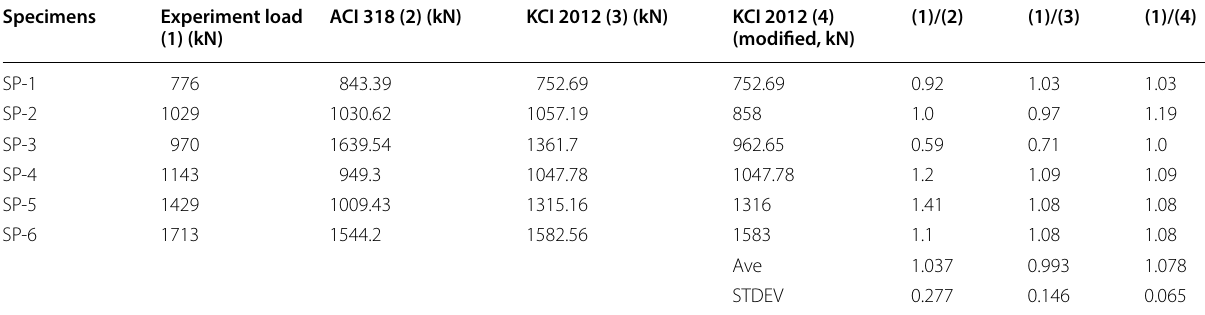
Table 5 Punching shear strength by concrete